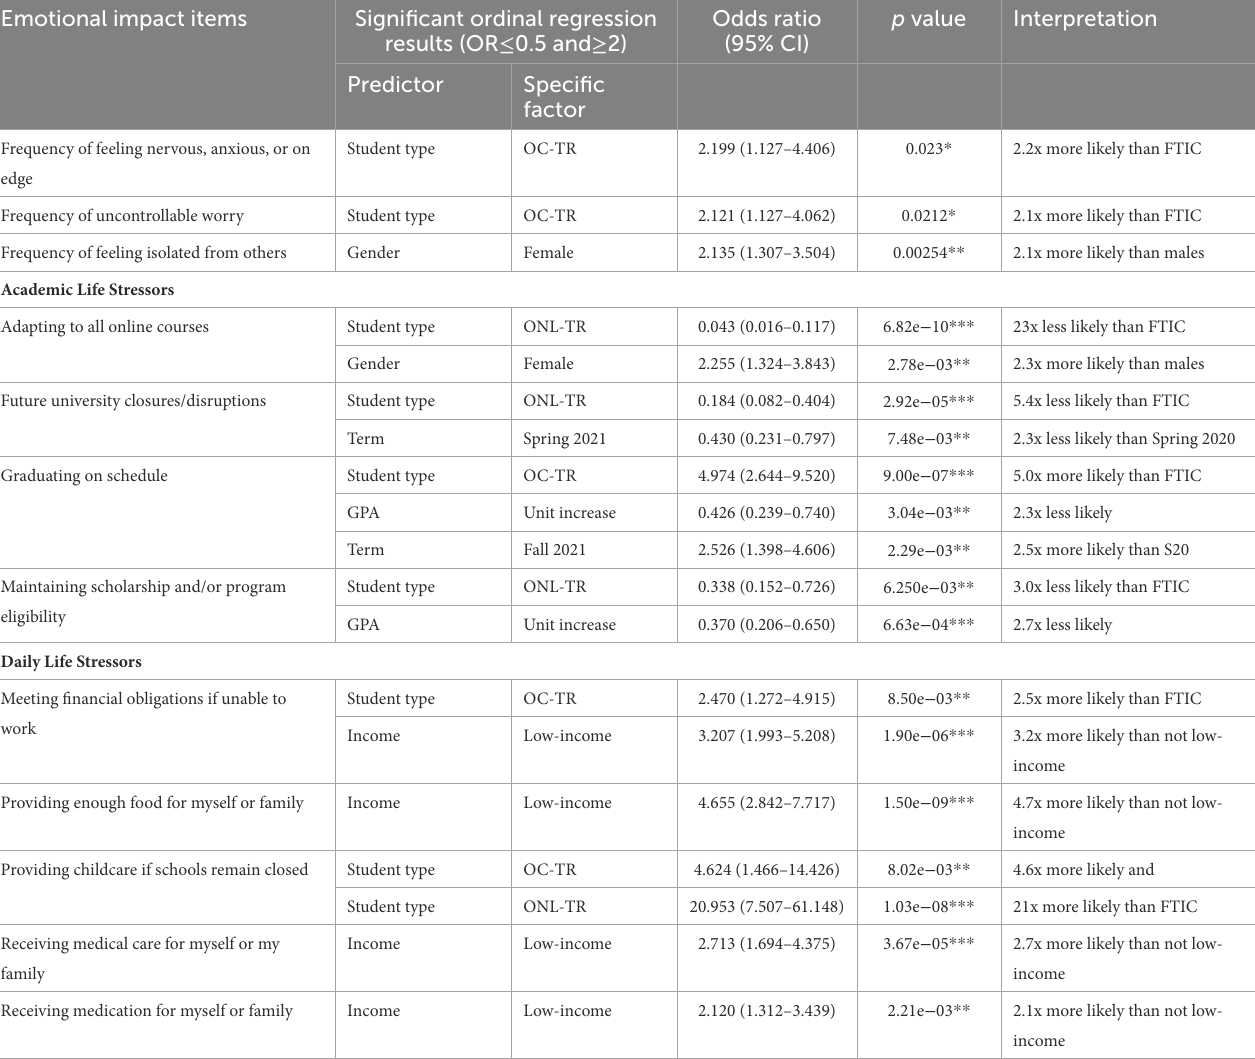
TABLE 3 Summary of significant predictors of responses to academic and daily stressors and emotional impact-related survey items. Emotional impact